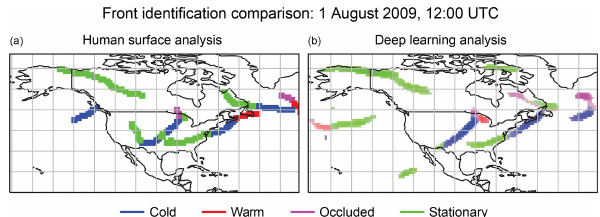
Figure 4. Side-by-side comparison of CSB (a) and DL-FRONT (b) front boundaries for 1 August 2009 12:00:00. The CSB fronts were drawn three grid cells wide. The intensities of the colors for the different front types in the DL-FRONT image represents the likelihood value (from 0.0 to 1.0) associated with each grid